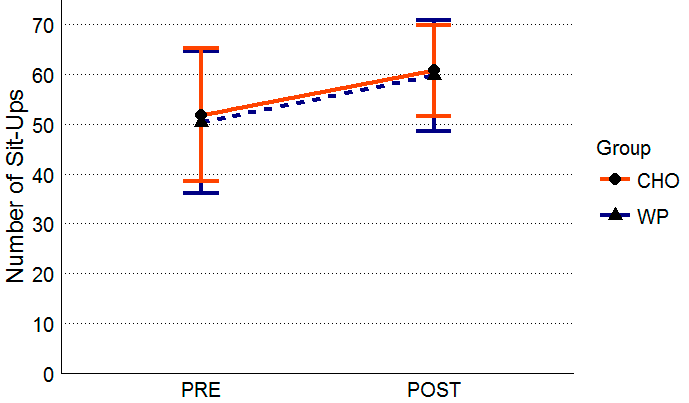
Figure 3. Sit-up Performance. All data are presented as means ± standard deviation values.